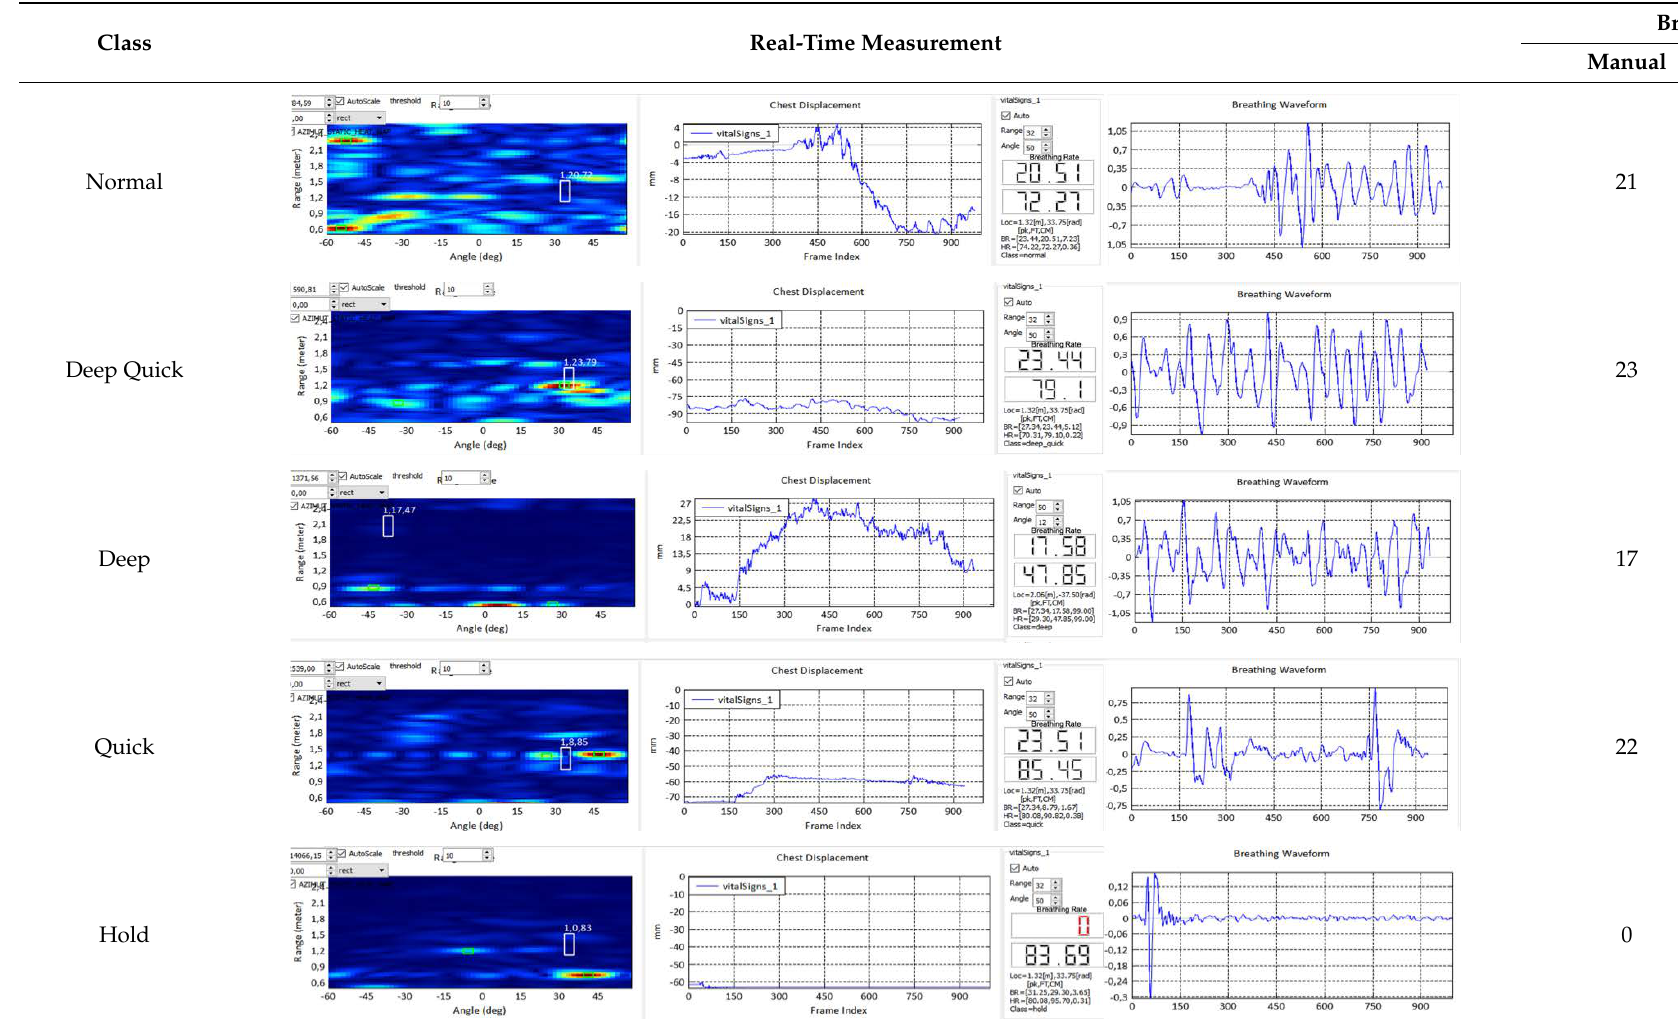
Table 6. Real-time measurement using TI-IWR 1443 for five breathing